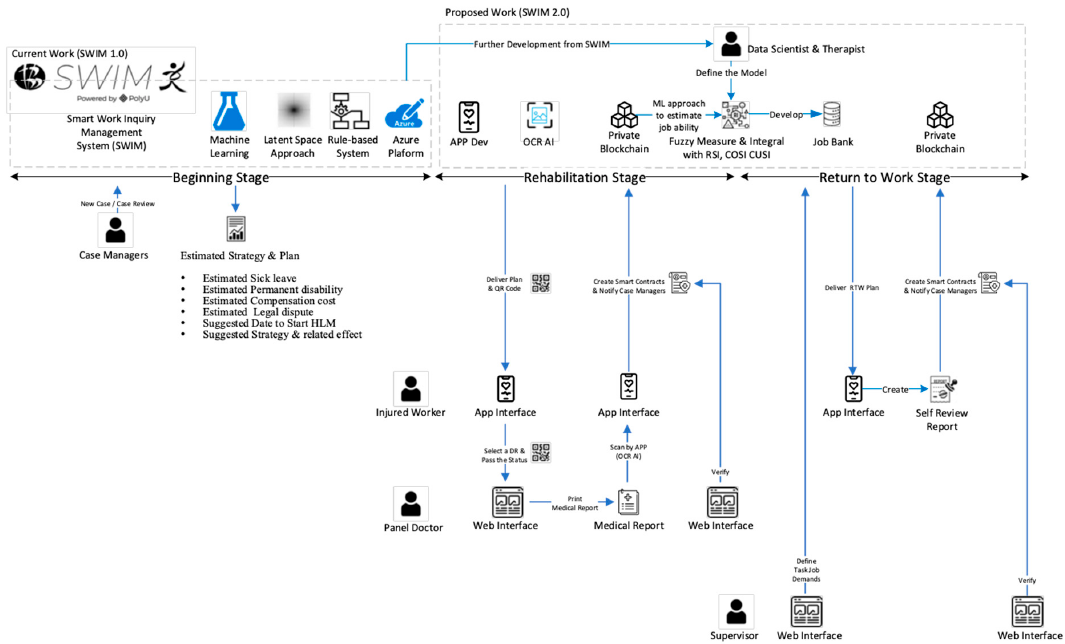
Figure 12. Overall flow of new case management in SWIM 2.0.